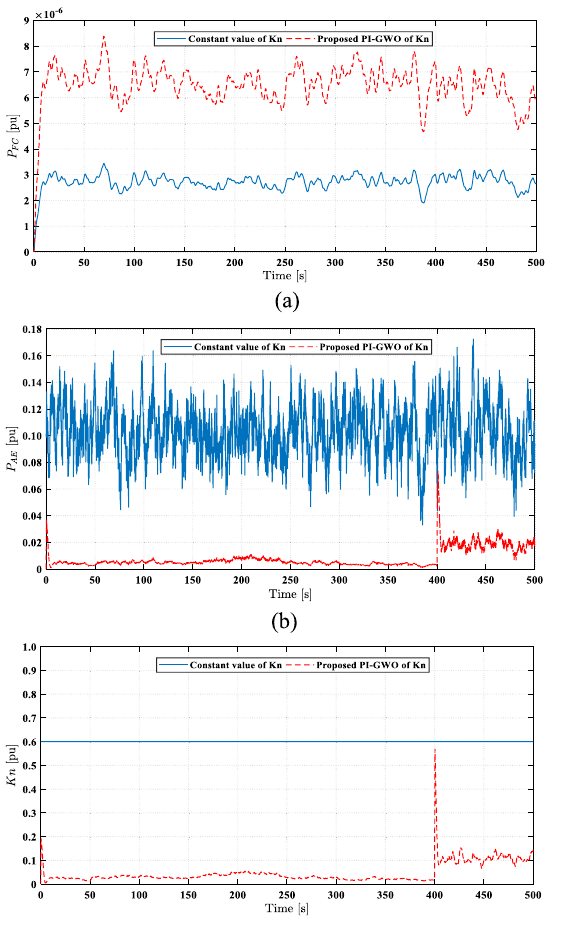
Fig. 8 The response of a fuel cell power of case 1, b power fed into AE of Case 1, and c value of Kn of Case 1